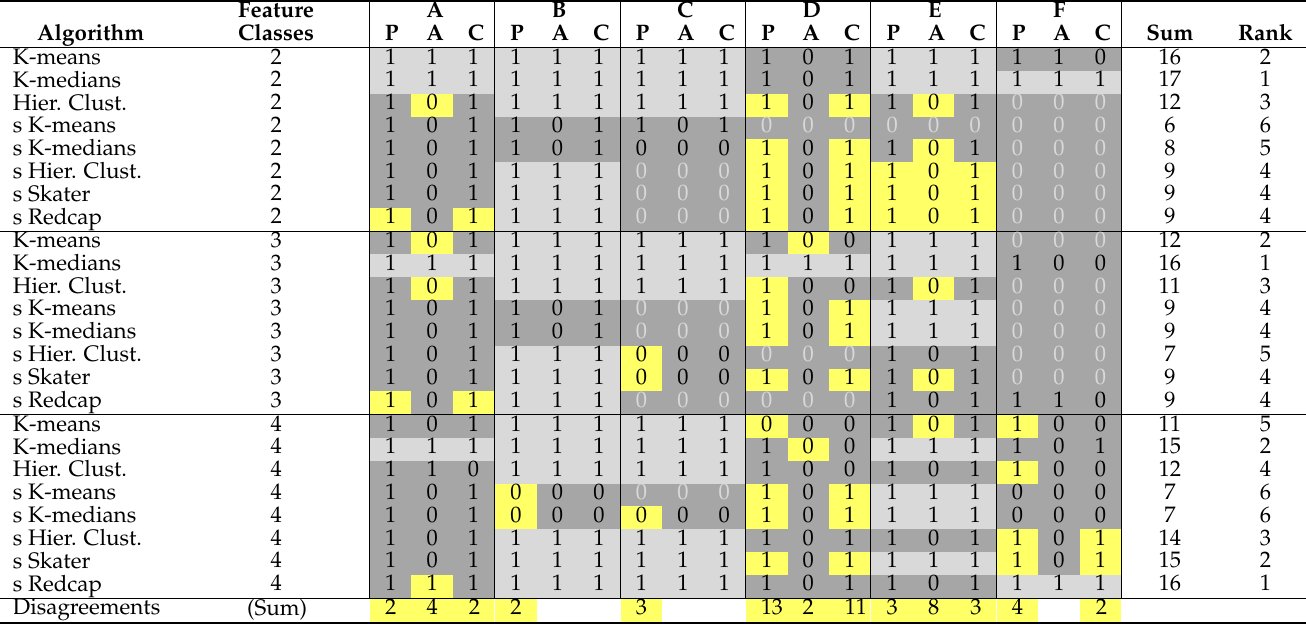
maps (Figure 10), Redcap overestimated the extent of one feature (D) and underestimated another (E). Table 12. Visual evaluation by a panel composed of one author (DM), a GIS analyst (DS) and an ecologist (DJ); for maps produced for individual polygons by clustering algorithms. Maps were ranked according to how well six nominated features (A–F in Figure 10) were captured by each algorithm, each with 2, 3, and 4 classes. Panellists first independently allocated scores, disagreements were highlighted, and the panellists re-evaluated their scores. Key: P—feature identified (1), not identified (0); A—feature has similar area (1), smaller or larger (0); C—feature contiguous (1), not contiguous (0), ‘s’ prefix denotes spatially constrained algorithm. 1 1 1 = panellists agree that feature recognised by algorithm using all criteria- 0 0 0 feature not recognised using any criteria- Dark grey cells indicate panellists agree with individual criteria, 0/1 one panellist disagrees. For all cells, there was 86.3% agreement by all panellists. Panellists most often disagreed on whether feature D was captured. Nonspatial K-medians (all classes) has the highest overall score, followed by nonspatial K-means. For 4 classes, Redcap ranked slightly higher than nonspatial K-medians.